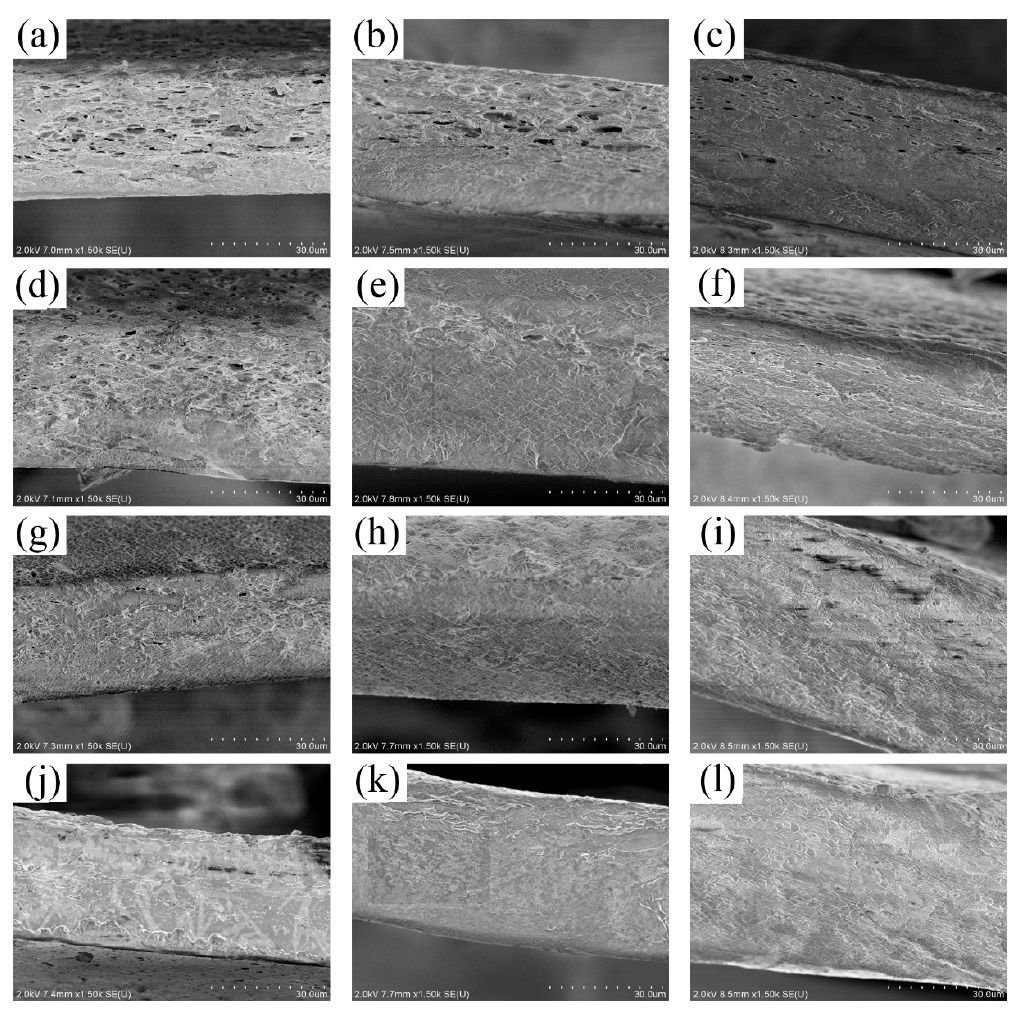
Figure 1. SEM images of the cross sections of films EG1–EG4 ( a – d ), EGA1–EGA4 ( e – h ), EGC1–EGC4 ( i – l ).